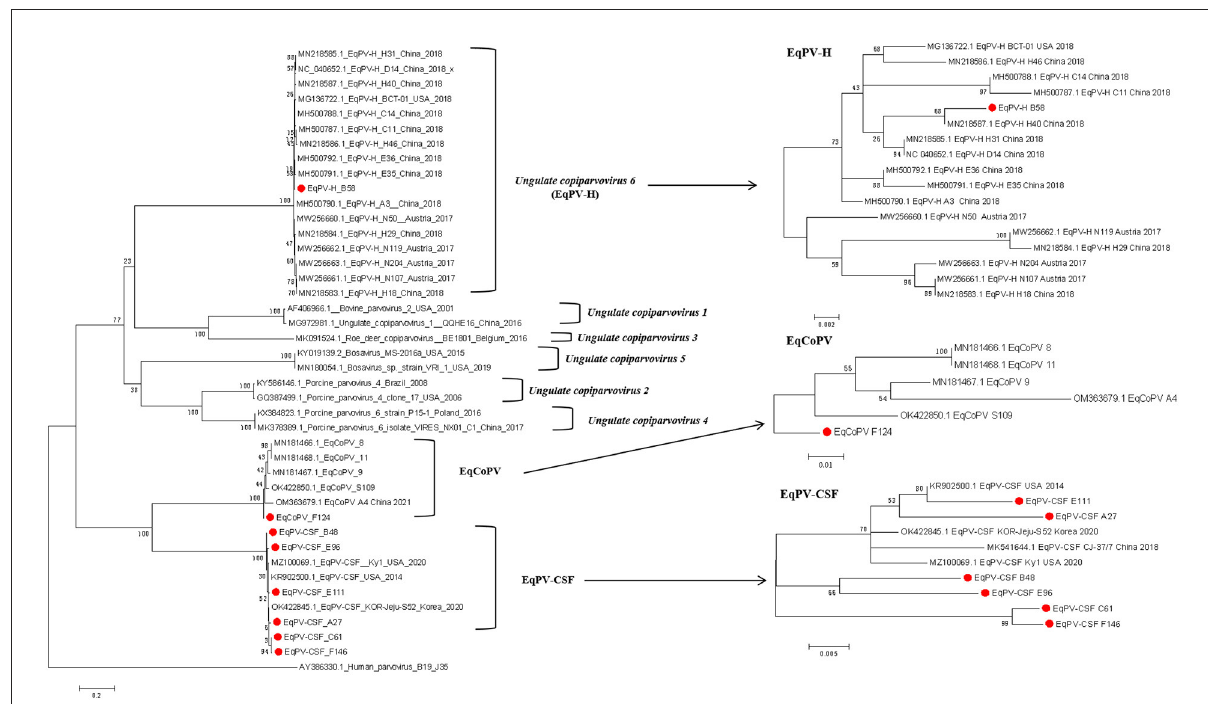
FIGURE1 Phylogenetic analysis based on complete NS1 amino acid sequences of the genus Copiparvovirus. Chinese The Chinese strains isolated in this study are indicated by circles filled in